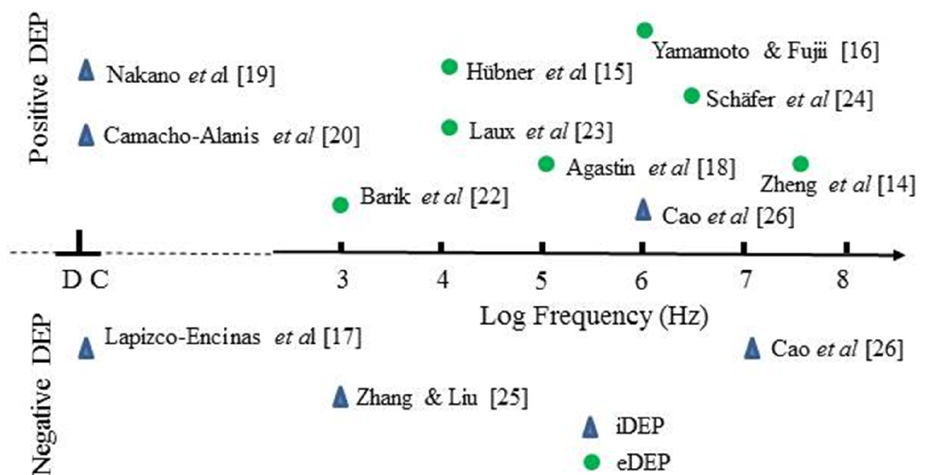
Figure 3. Insulator-based (iDEP) and electrode-based (eDEP) studies reported for bovine serum albumin (BSA). Most groups observed positive DEP, but two cases of negative iDEP have also been reported [17,25]. Cao et al. [26] report a DEP cross-over frequency between 1~10 MHz.